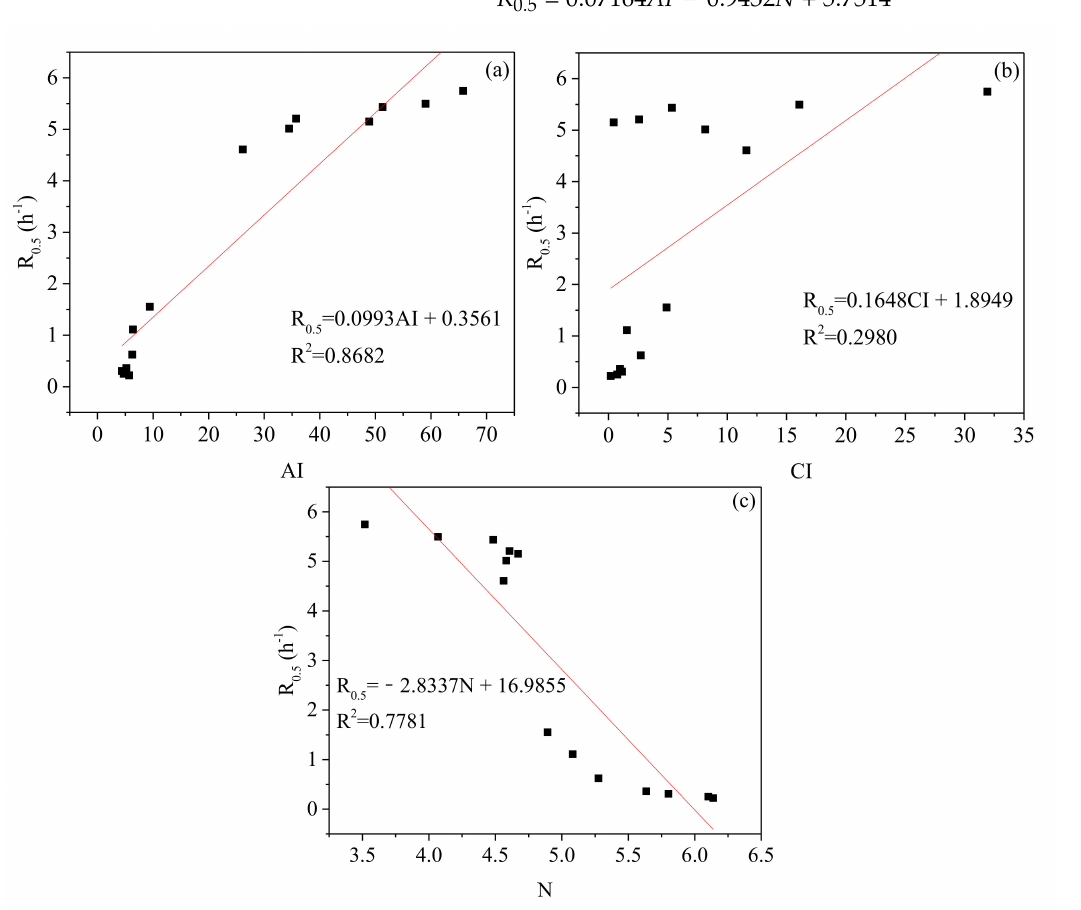
Figure 8. Relationships between individual structural properties and gasification reactivity index: ( a ) AI and R 0.5 , ( b ) CI and R 0.5 , ( c ) N and R 0.5